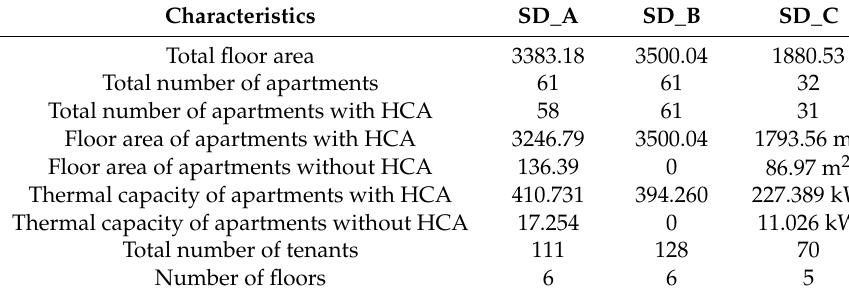
Table 1. Relevant building characteristics per each sub-division.